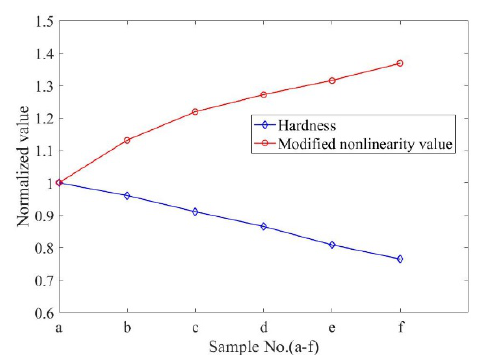
Figure 8. Variations in nonlinear parameters in steel specimens with different microstructures.